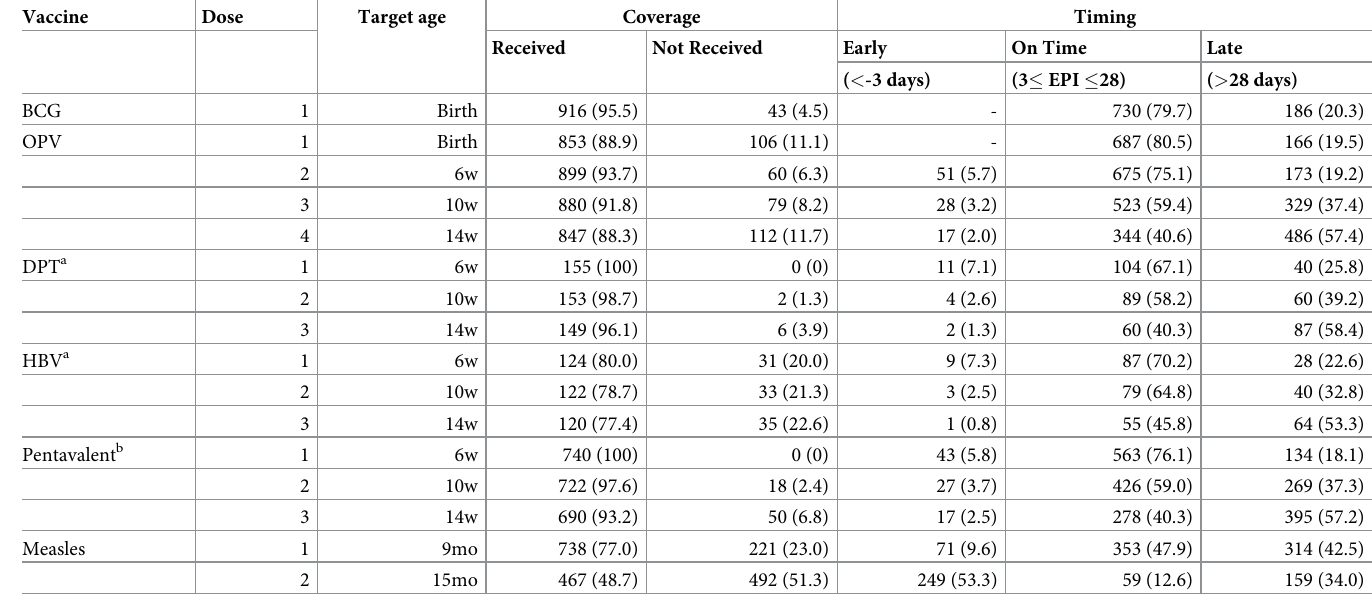
Table 2. Vaccine coverage and timeliness (N (%)) for the n = 959 children with complete vaccination histories. DPT and HBV (n = 155) were replaced with the penta- valent vaccine (n = 740) part way through the study hence children were eligible for one or other. Timeliness assumes a vaccine should be given within a -3 � days � 28 window around the EPI